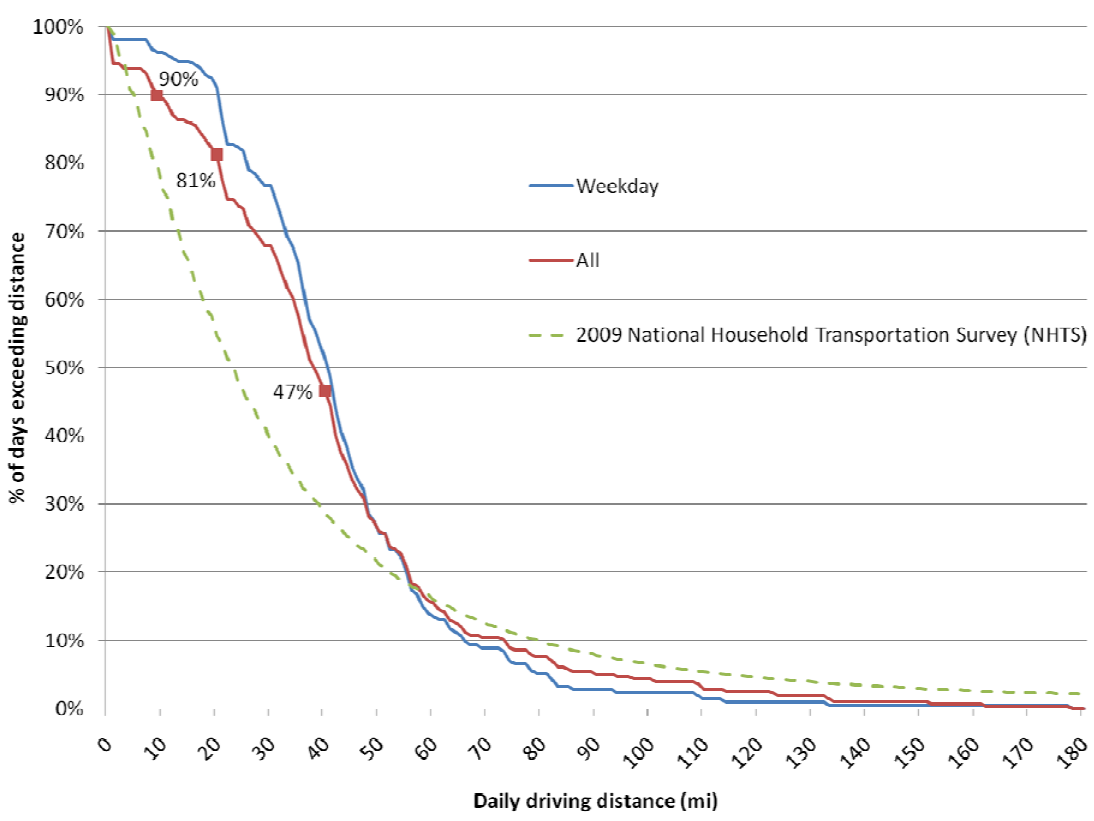
Figure 1. Percentage of days exceeding a given total driving distance ( travel days only